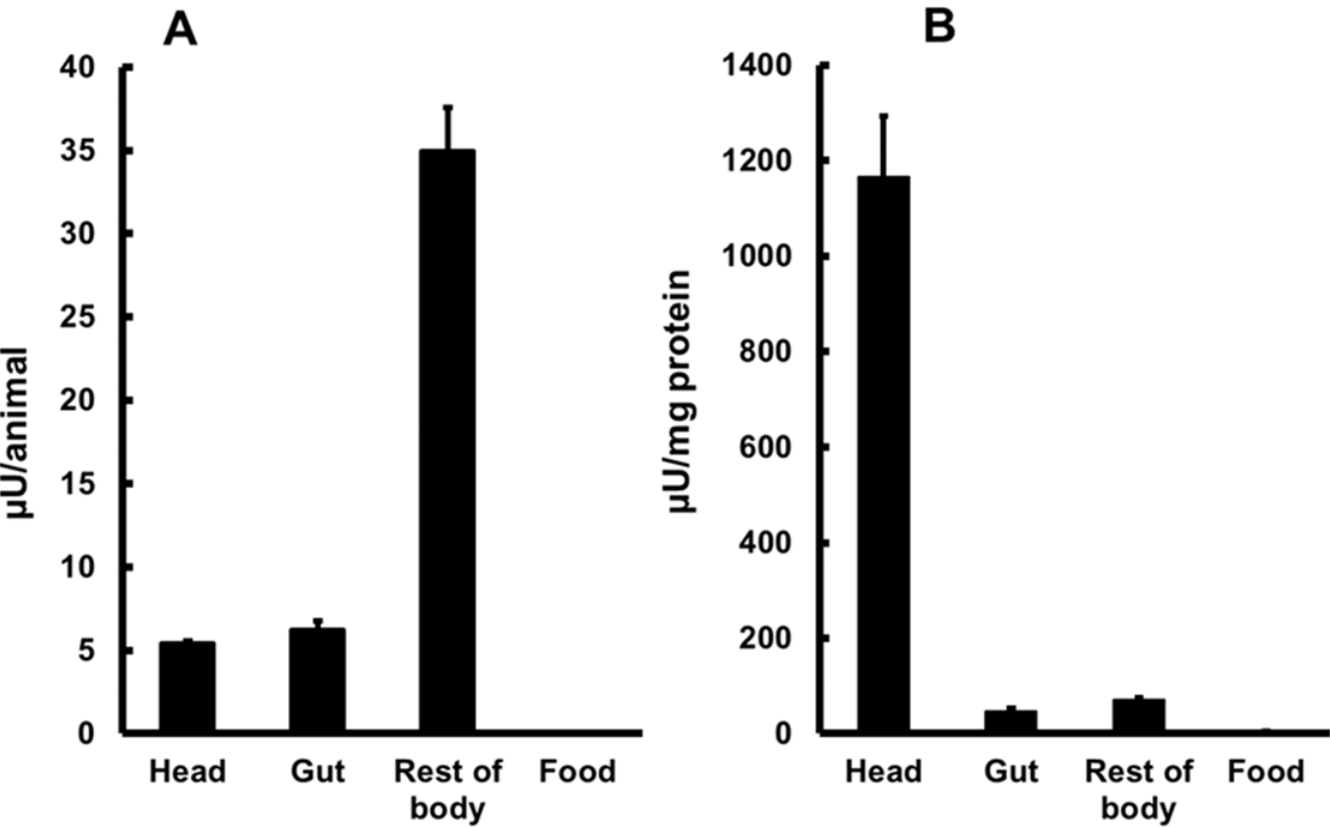
Fig 3. Beta-1,3-glucanase activity in head, gut, rest of body and food of Aedes aegypti larvae. (A) Activity per animal ( μ U/animal). (B) Specific activity ( μ U/mg protein). Insects were fed with cat food (Whiskas 1 ). Figures are means ± SEM of 2 experiments with 3 samples obtained from 50 insects